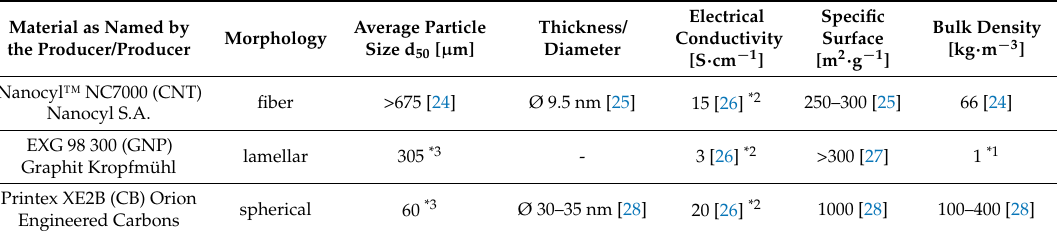
Table 1. Specifications of the used commercial carbon filler material